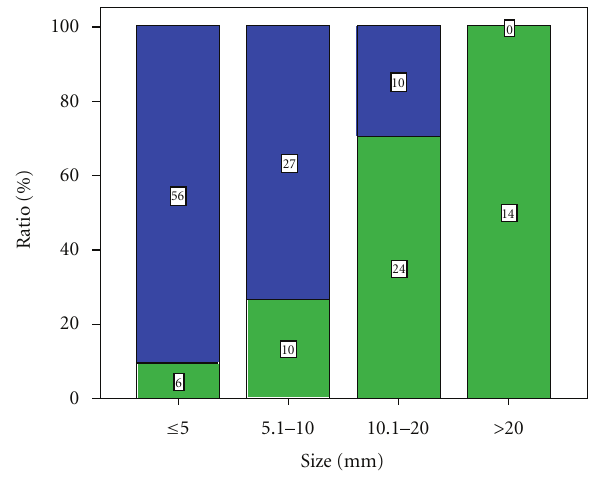
Figure 2: Detection rate based on tumor size.